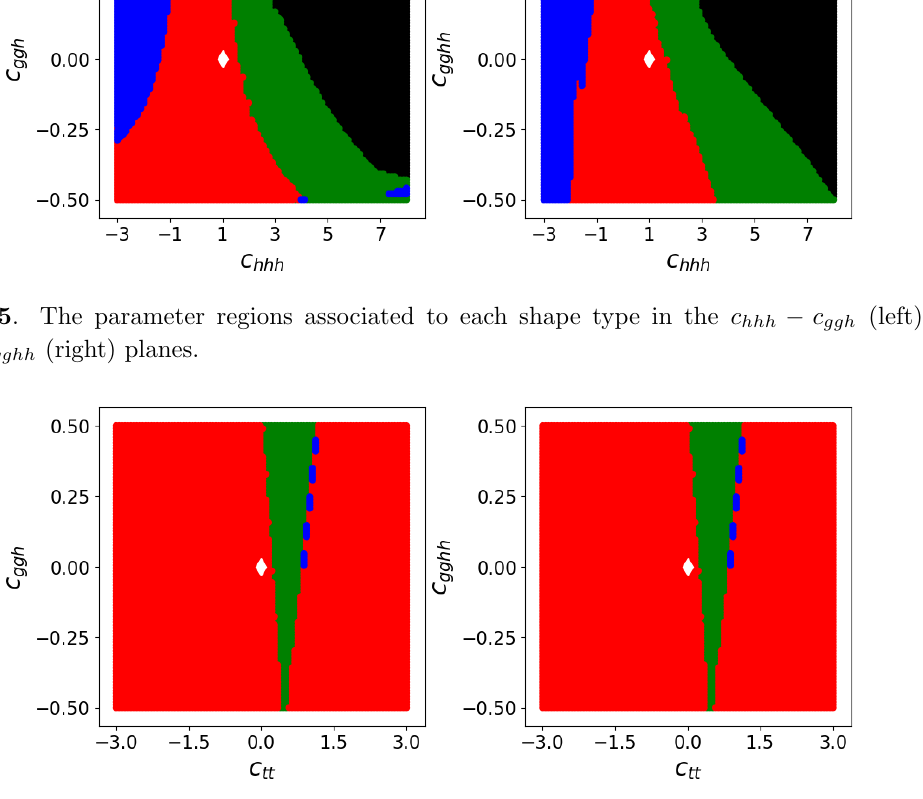
Figure 6 . The parameter regions associated to each shape type in the c tt (cid:0) c ggh (left) and c tt (cid:0) c gghh (right)